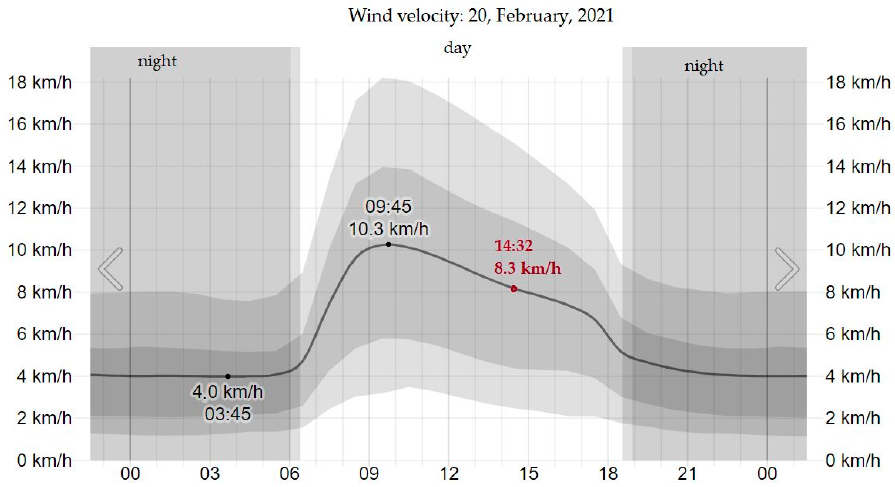
Figure 7. Wind velocity during experimentation.